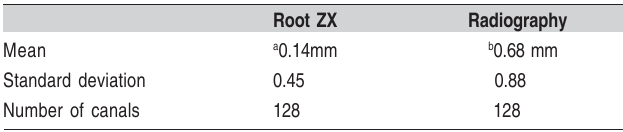
Table 3 – Number of cases in which the electronically and radiographically measured WL fell between scores 0 and 1.